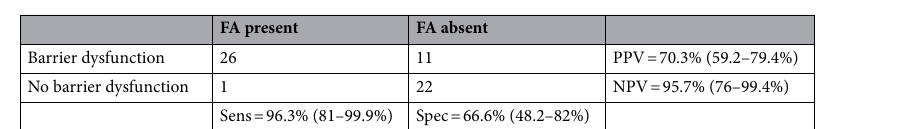
Table 2. Diagnostic performance of assessing barrier dysfunction in the terminal Ileum by pCLE for the diagnosis of Food Allergy (FA). Sens, sensitivity; Spec, specificity. PPV, positive predictive value; NPV, negative predictive value. (95% CI).